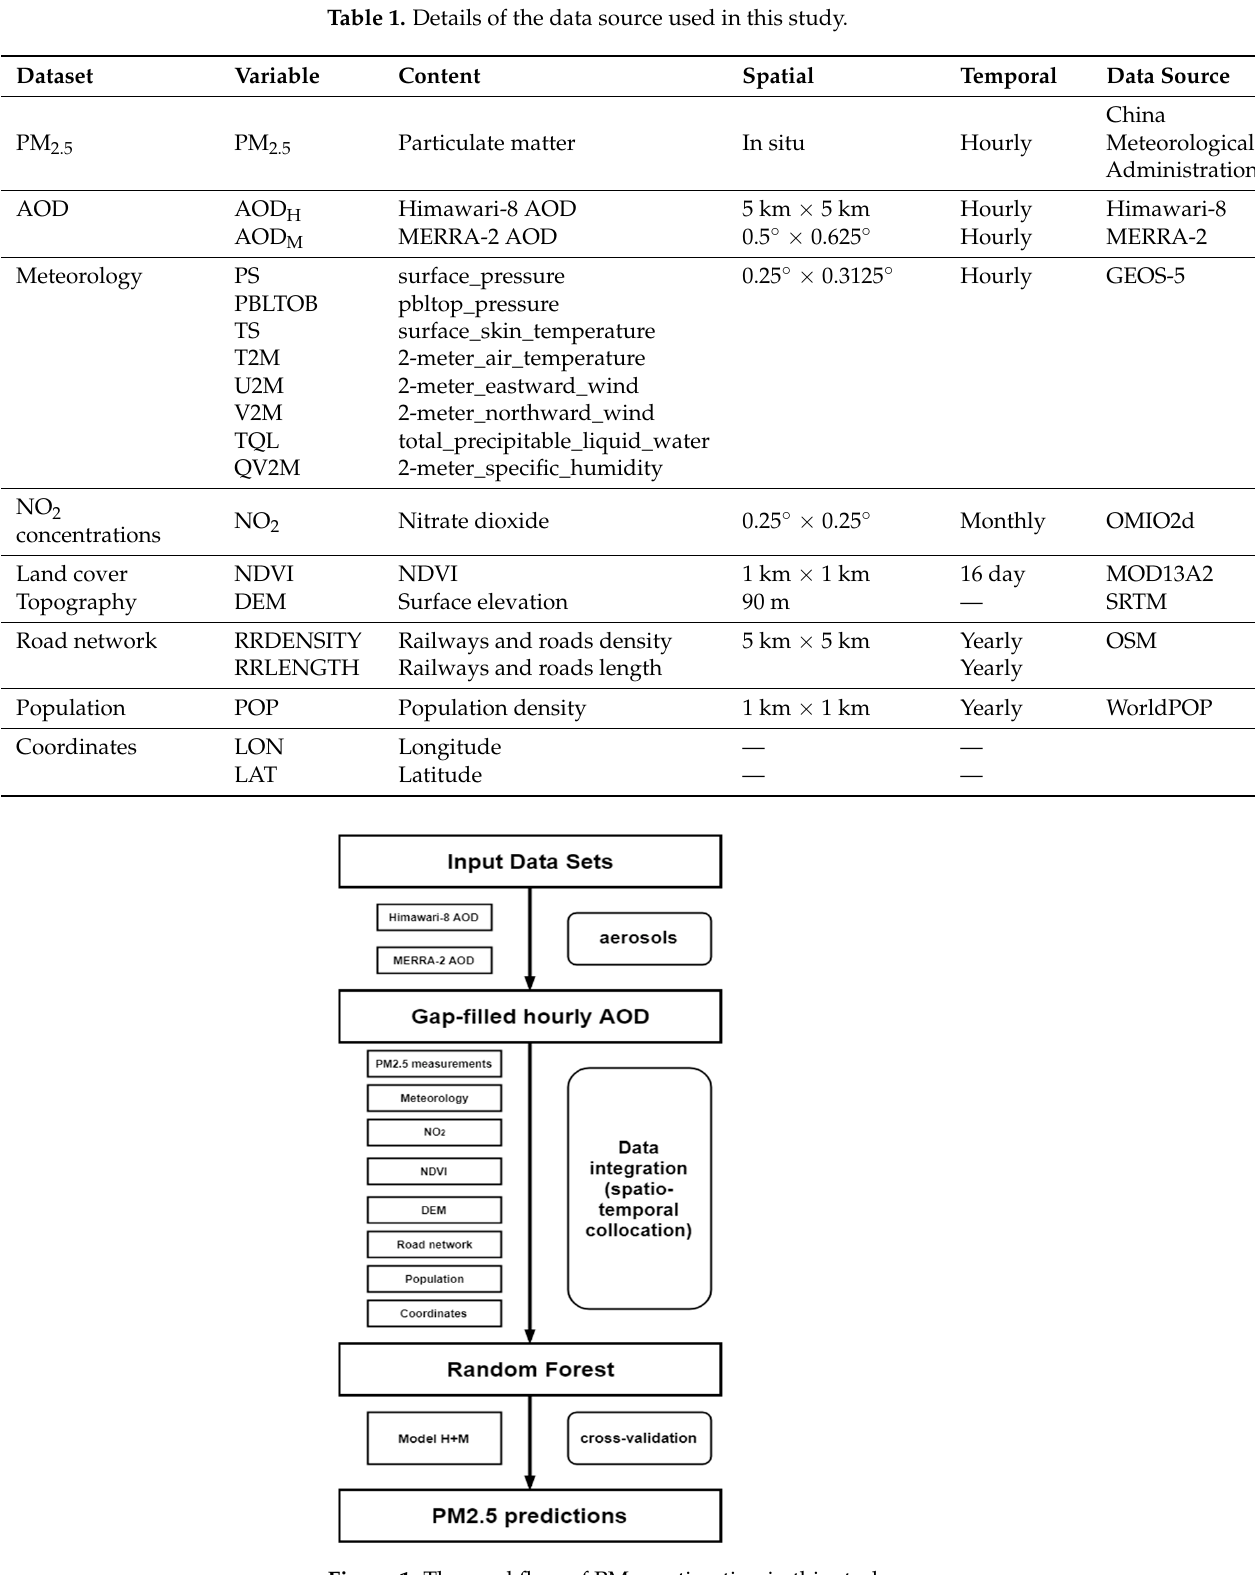
Figure 1. The workflow of PM 2 . 5 estimation in this study.